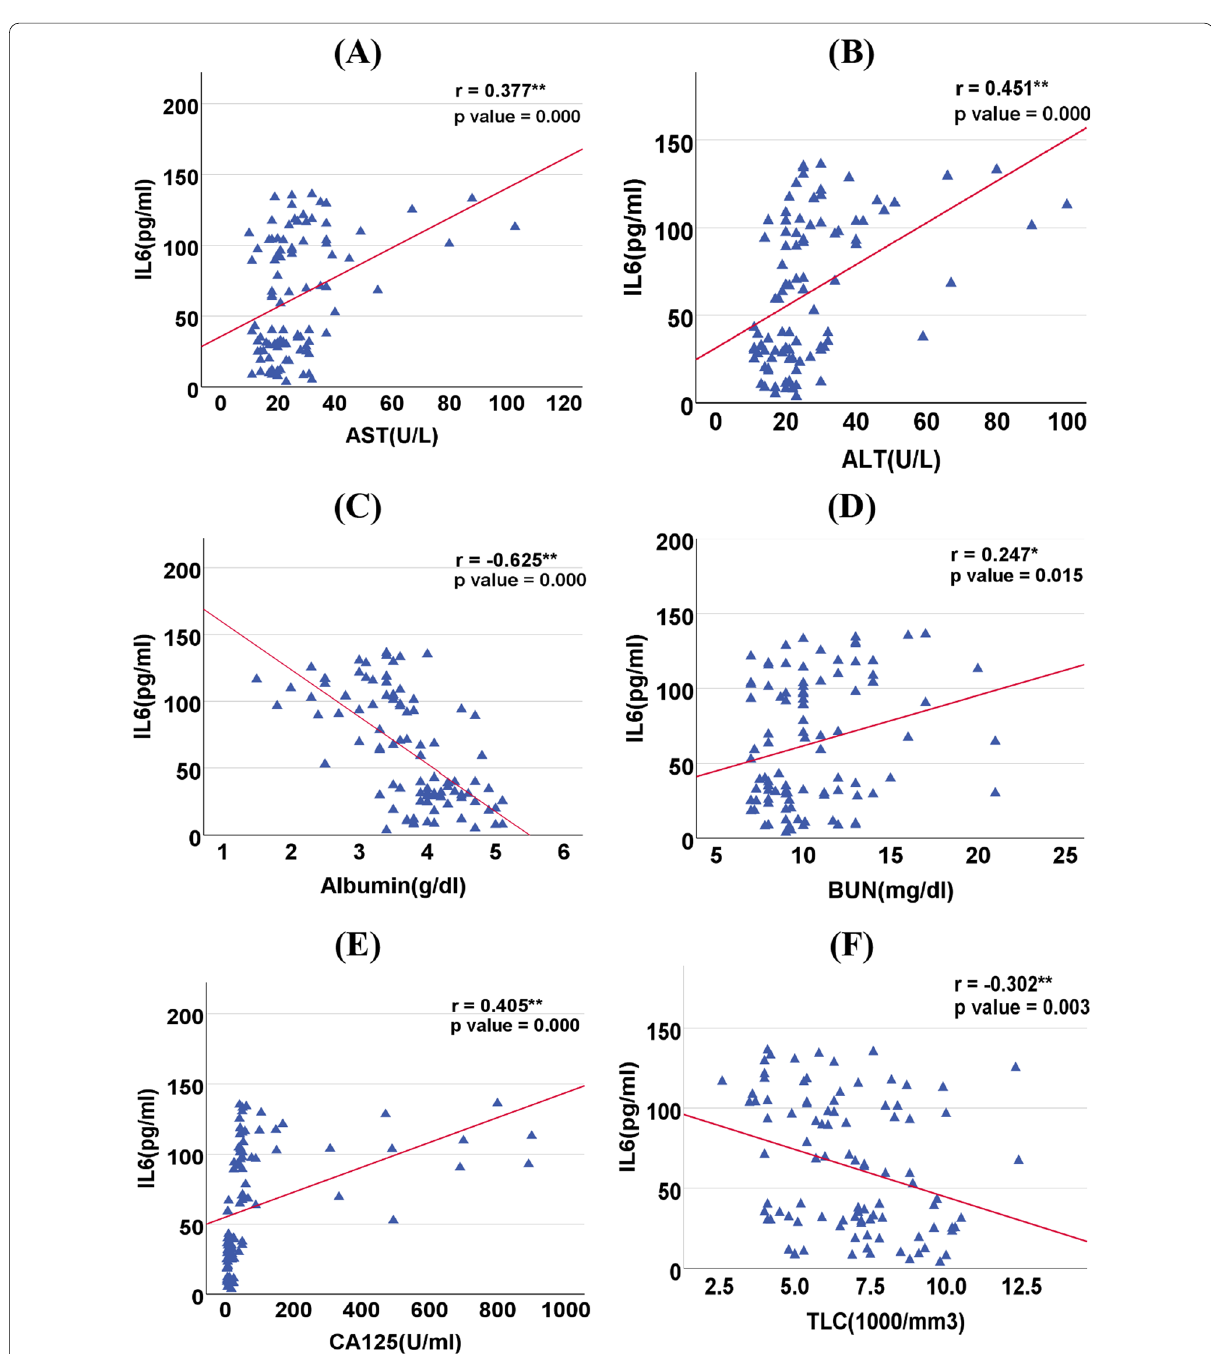
Fig. 5 Correlation between IL6 (pg/ml) with A AST, B ALT, C Albumin, D BUN, E CA125 and F TLC among ovarian cancer and control groups.r, Pearson’s correlation coefficient. * P < 0.05; ** P < 0.01 and *** P < 0.001. Abbreviations: IL Interleukin, AST Aspartate aminotransferase, ALT Alanine aminotransferase, BUN Blood urea nitrogen, CA125 Cancer antigen 125, TLC Total leucocytic